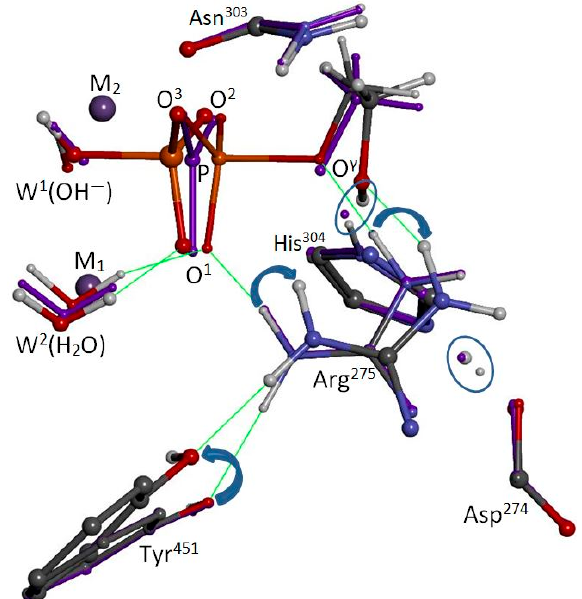
Figure 3. Superposition of reactant, transition, and product states of methylphosphate hydrolysis. Representations are small ball-and-stick, violet ball-and-stick, and large ball-and-stick, respectively. Most atoms of the model are hidden from view. W 1 (OH − ) at upper left attacks the M 1 / M 2 -bound methylphosphate dianion (CH 3 OPO 32 − ), causing rupture of the P-O γ bond. Reaction motion primarily involves inversion of the P center and transfer of H + from His 304 to O γ . Post-TS withdrawal of the product alcohol (CH 3 OH) to the right induces Arg 275 to swing away from O 1 , now an atom belonging to the hydrolysis product (HPO 42 − ). At the same time, Tyr 451 rotates inward to maintain an H-bond with Arg 275 . W 2 (H 2 O) is H-bonded to O 1 throughout the reaction. Proton movements to and from His 304 are circled; selected H-bonds are indicated by green lines.